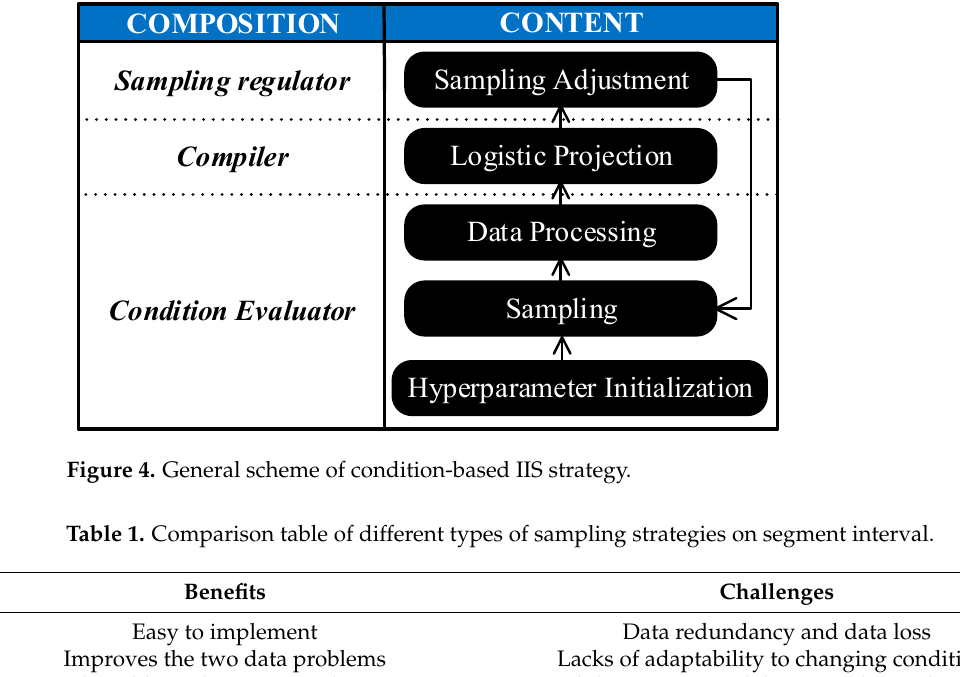
4 of 17 Table 1. Comparison table of different types of sampling strategies on segment interval. No. Literatures